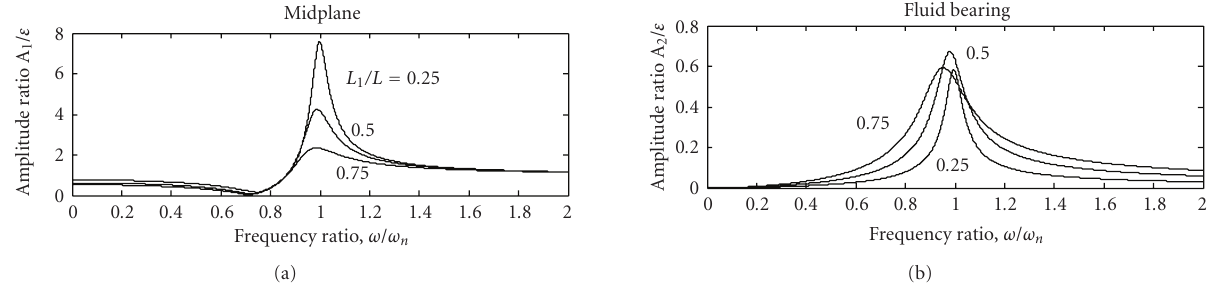
Figure 6: Response curves for various locations of disk. Ro = 0.5, ao = 180 ◦ .